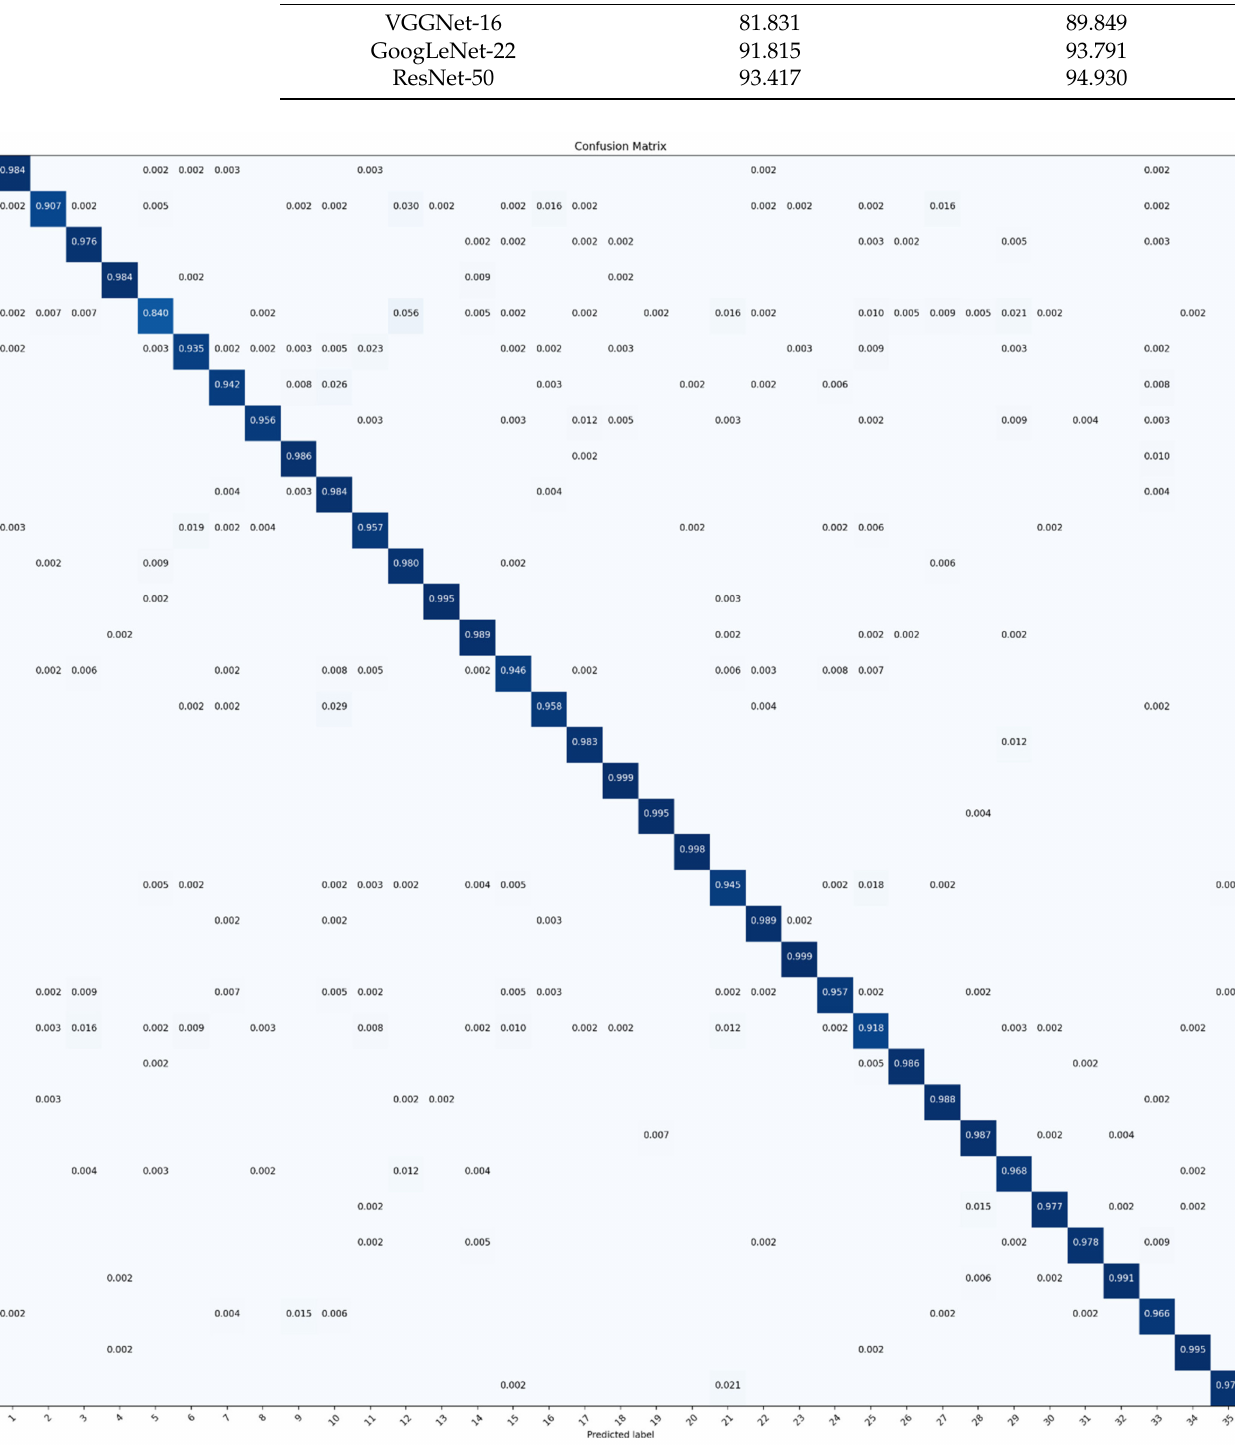
Figure 8. CM of ResNet-50 derived with the RSI-CB